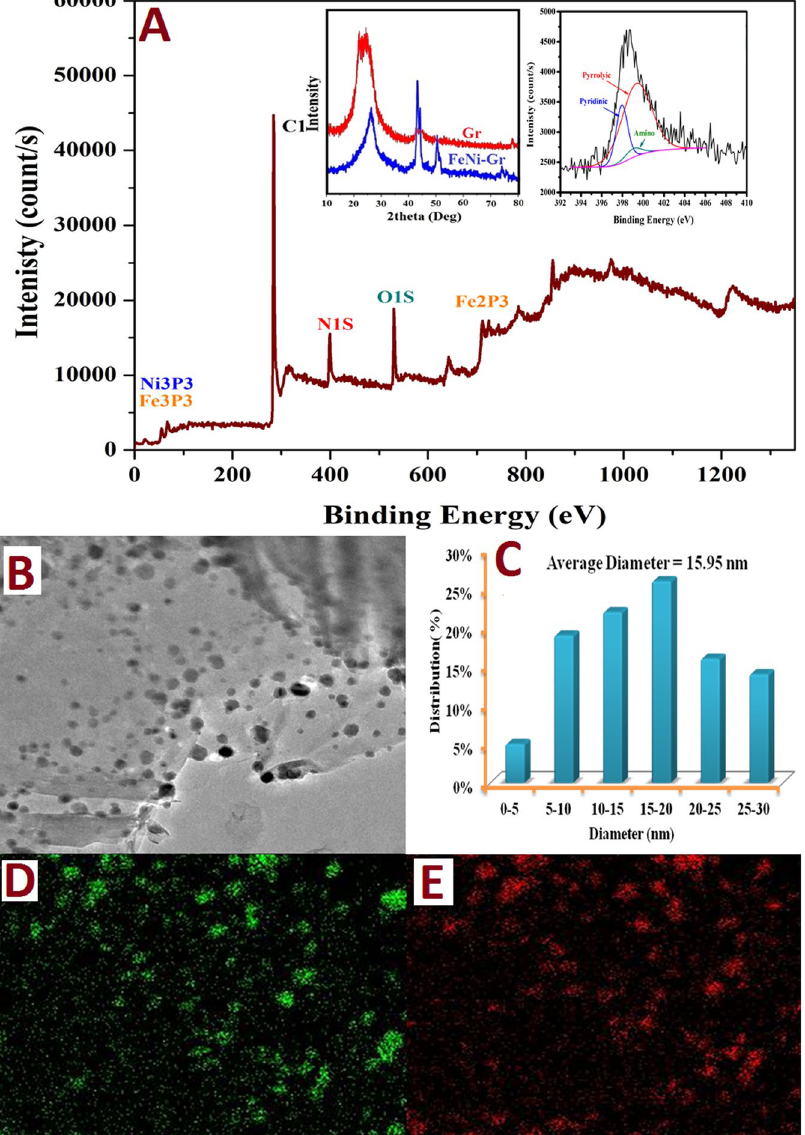
Figure 1. ( A ) XPS spectra for the FeNi@ N-doped graphene after the sintering process. Inset (left) demonstrates the analysis of N1S peak in the XPS spectrum. Inset (right) displays the XRD patterns for the pristine and bimetallic nanoparticles-decorated graphene, ( B ) TEM image, ( C ) size distribution of the metallic nanoparticles, and elemental mapping images ( D ; nickel and E ;